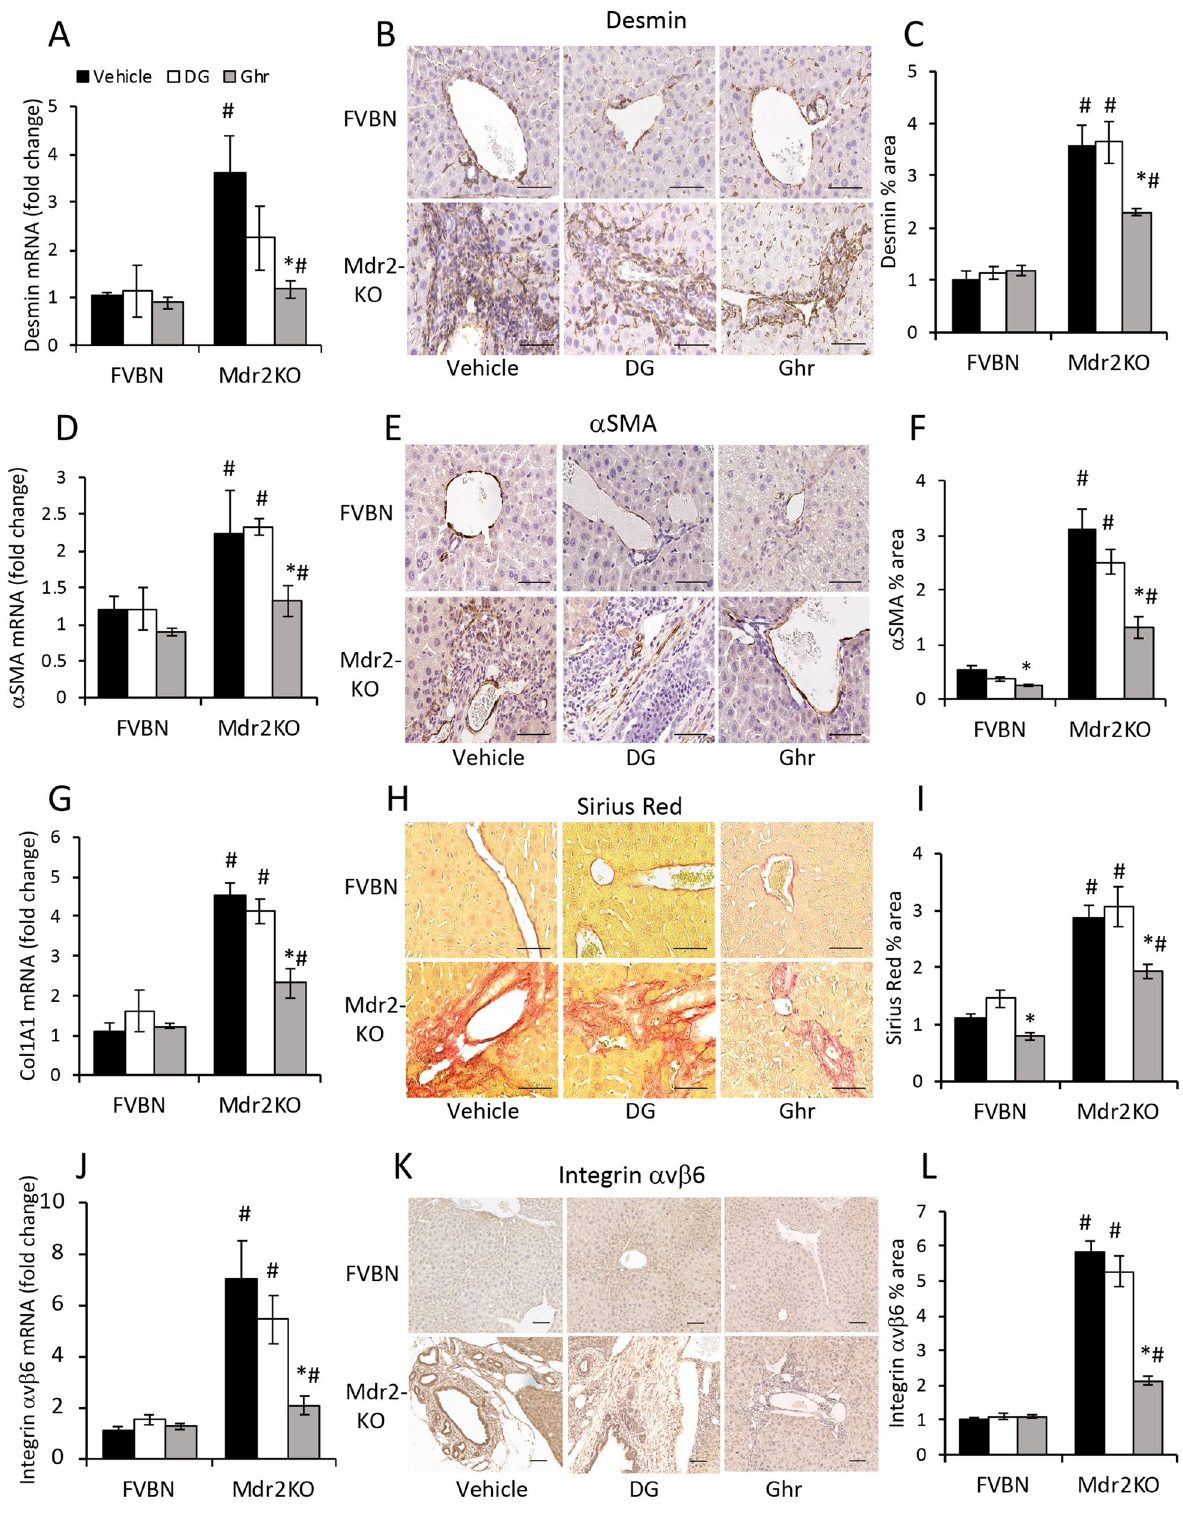
Figure 6. Ghrelin reduces the expression of fibrosis markers in livers of Mdr2KO mice. Liver samples from male FVBN and Mdr2KO mice treated with vehicle, DG or Ghr, were used. Desmin mRNA (A) and protein (B, C) , αSMA mRNA (D) and protein (E, F) , markers of HSC proliferation and activation were detected and quantified by RT-qPCR, IHC and image analysis as described under Methods. (G) Collagen 1A1 (Col1A1) mRNA was assayed by RT-qPCR. (H, I) Collagens I and III were assessed by Sirius Red staining of paraffin sections of liver from FVBN and Mdr2KO mice. (J) Integrin αvβ6 mRNA expression was determined by RT-qPCR. (K) Representative images of integrin αvβ6 IHC in sections of liver. (L) Quantification of αvβ6 protein expression in the liver using analysis of IHC images. Number of animals in each treatment group, 4. Number of sample replicates in RT-qPCR assays, 3. Number of images for each IHC sample, 10. p < 0.05. *, DG or Ghr vs vehicle. #, Mdr2KO vs FVBN